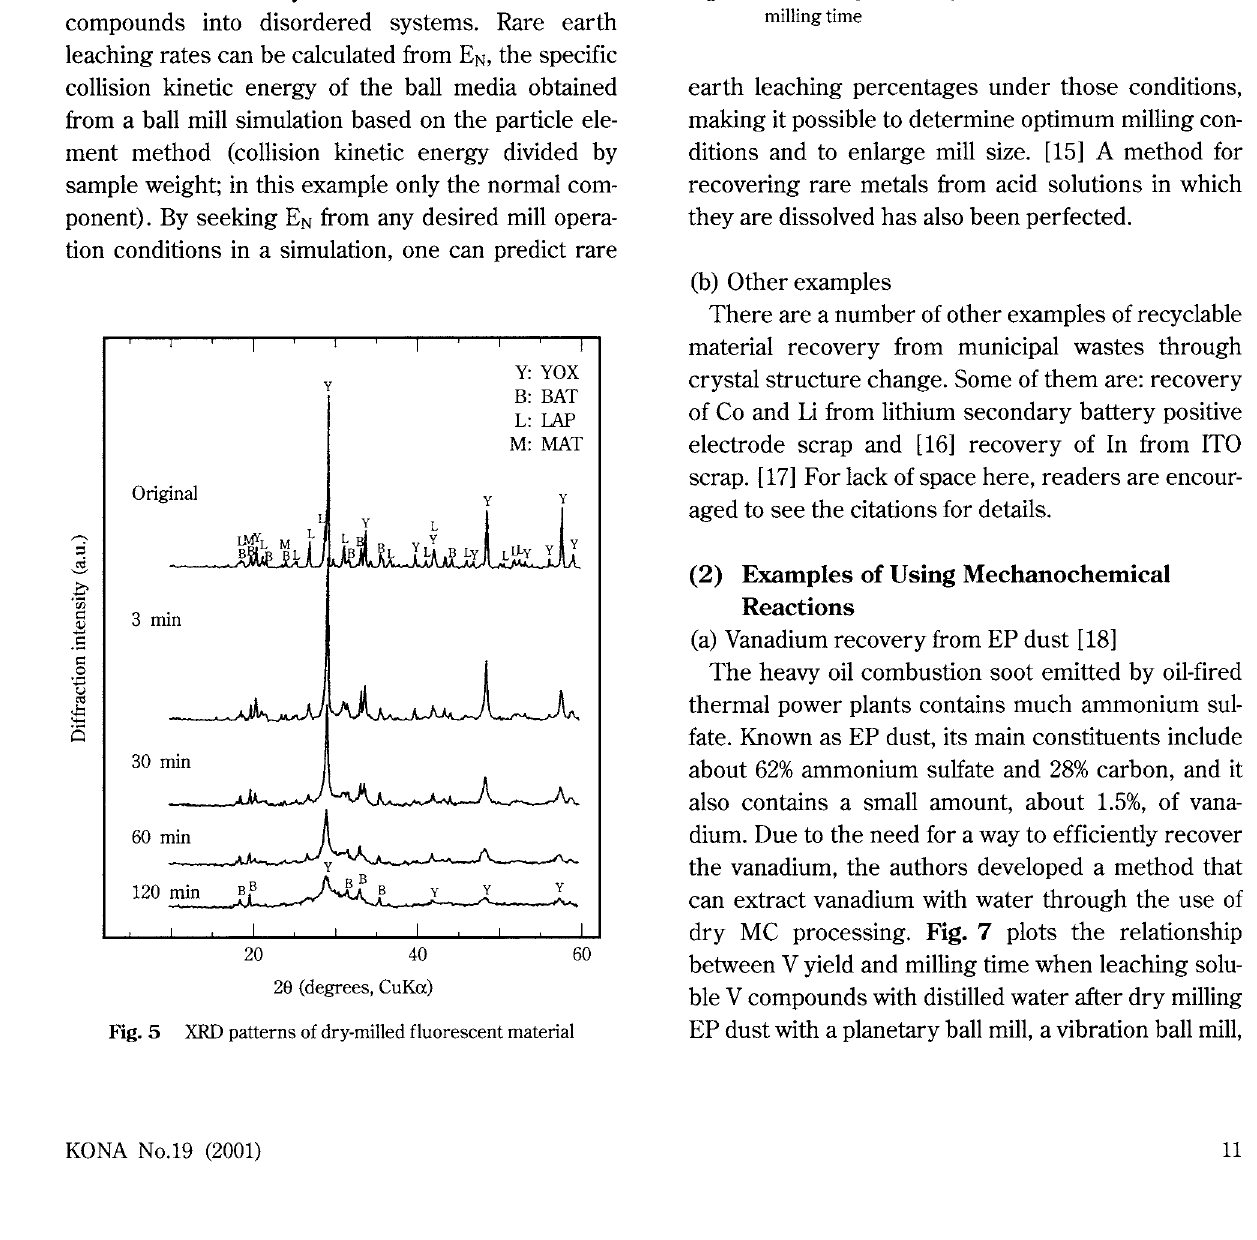
Relationship between yield of extracted rare earths and milling